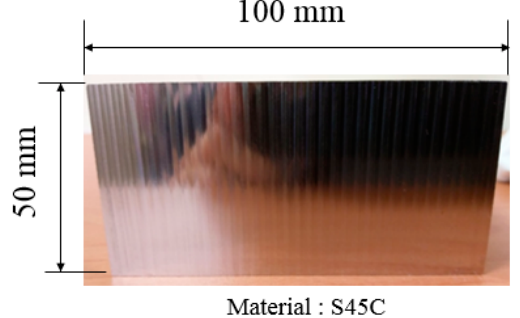
Figure 16. Workpiece dimension and finished workpiece.